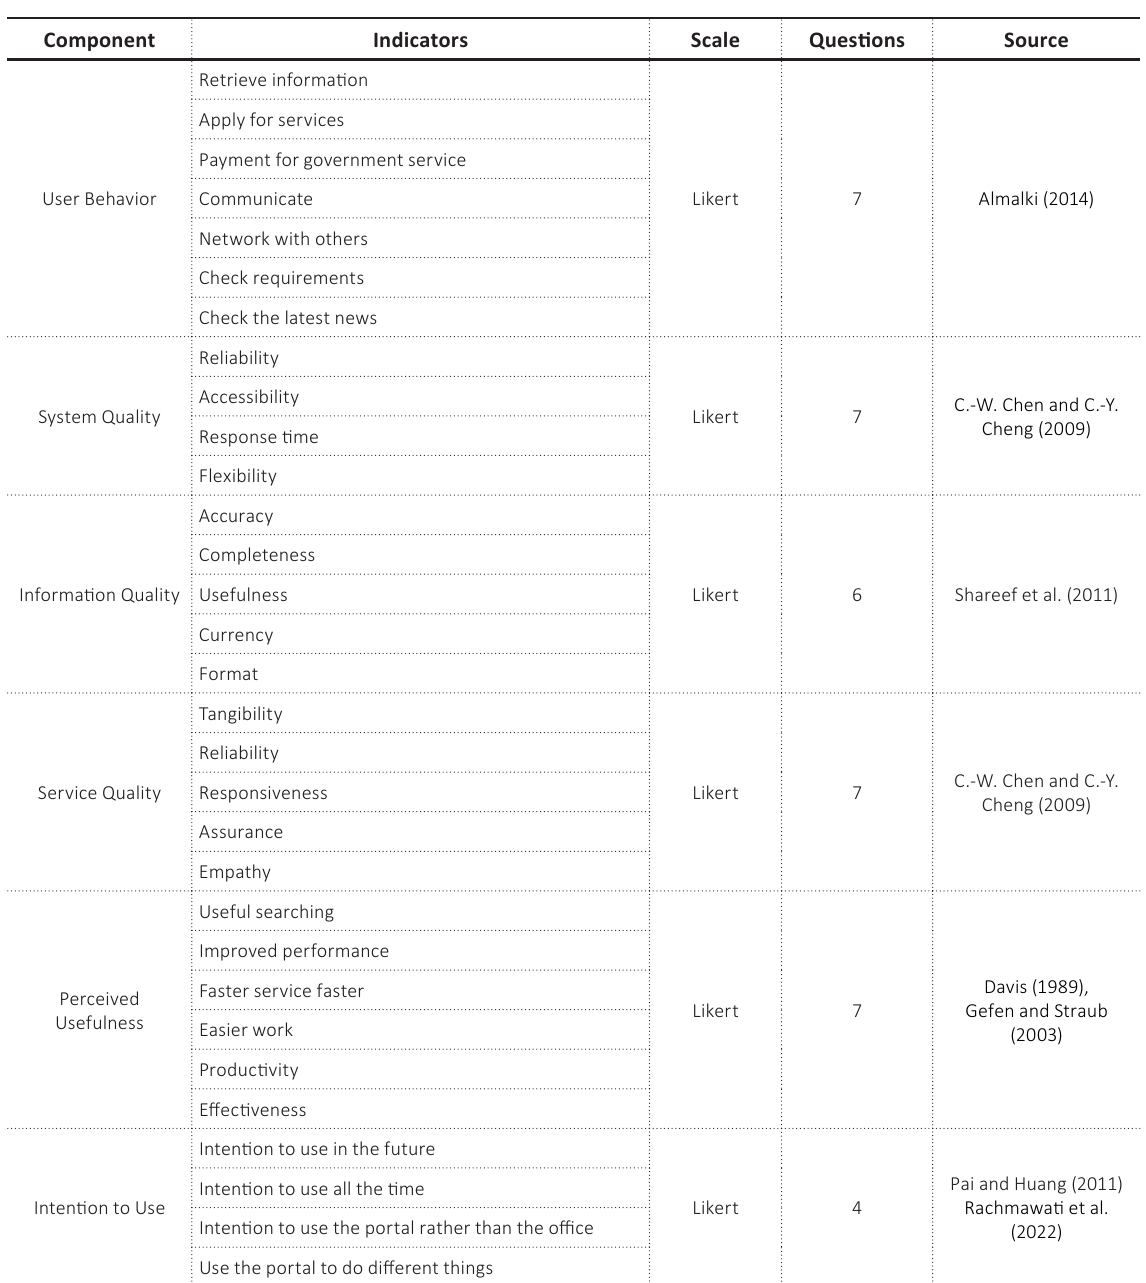
Table 1. Independent